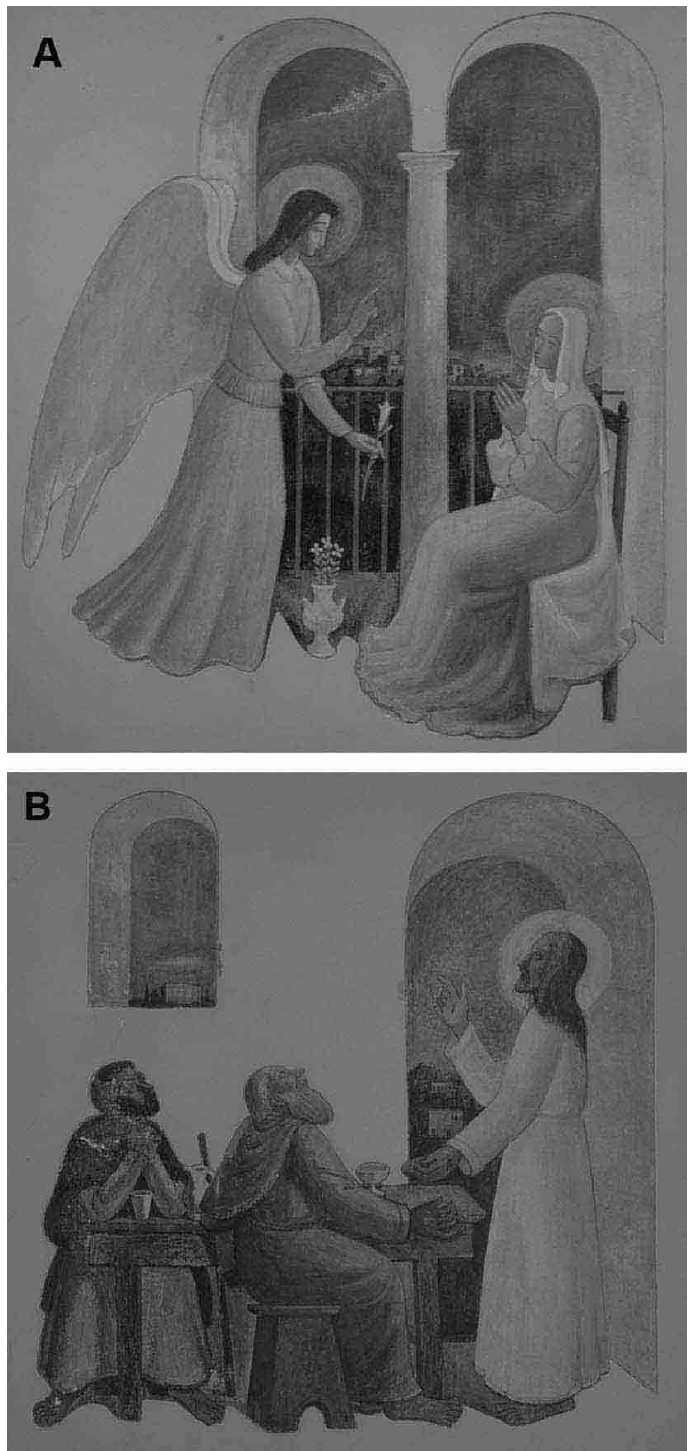
Fig. 1 – Virgin Annunciation (A) and Supper at Emmaus (B), frescoes painted by Pennacchi in 1947 in the Catholic Chapel of the Hospital das Clínicas (São Paulo City).